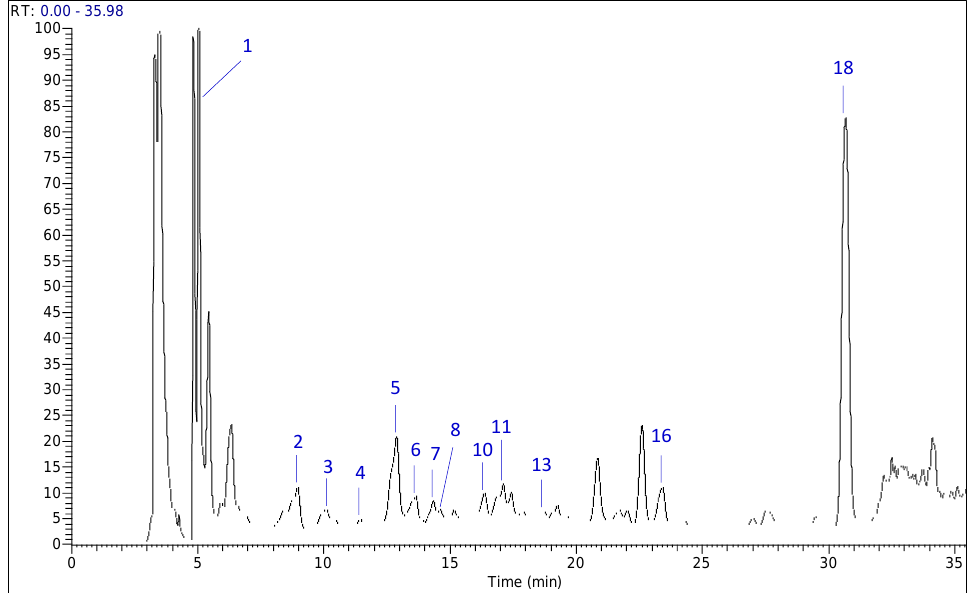
Figure 1. HPLC – MS chromatogram of phenolic compounds in Paralepista flaccida extract detected at Figure 1. HPLC–MS chromatogram of phenolic compounds in Paralepista flaccida extract detected 280 nm. at 280 nm. Table 2. Phenolic acids and related compounds characterized by HPLC – MS 1 . Table 2. Phenolic acids and related compounds characterized by HPLC–MS 1